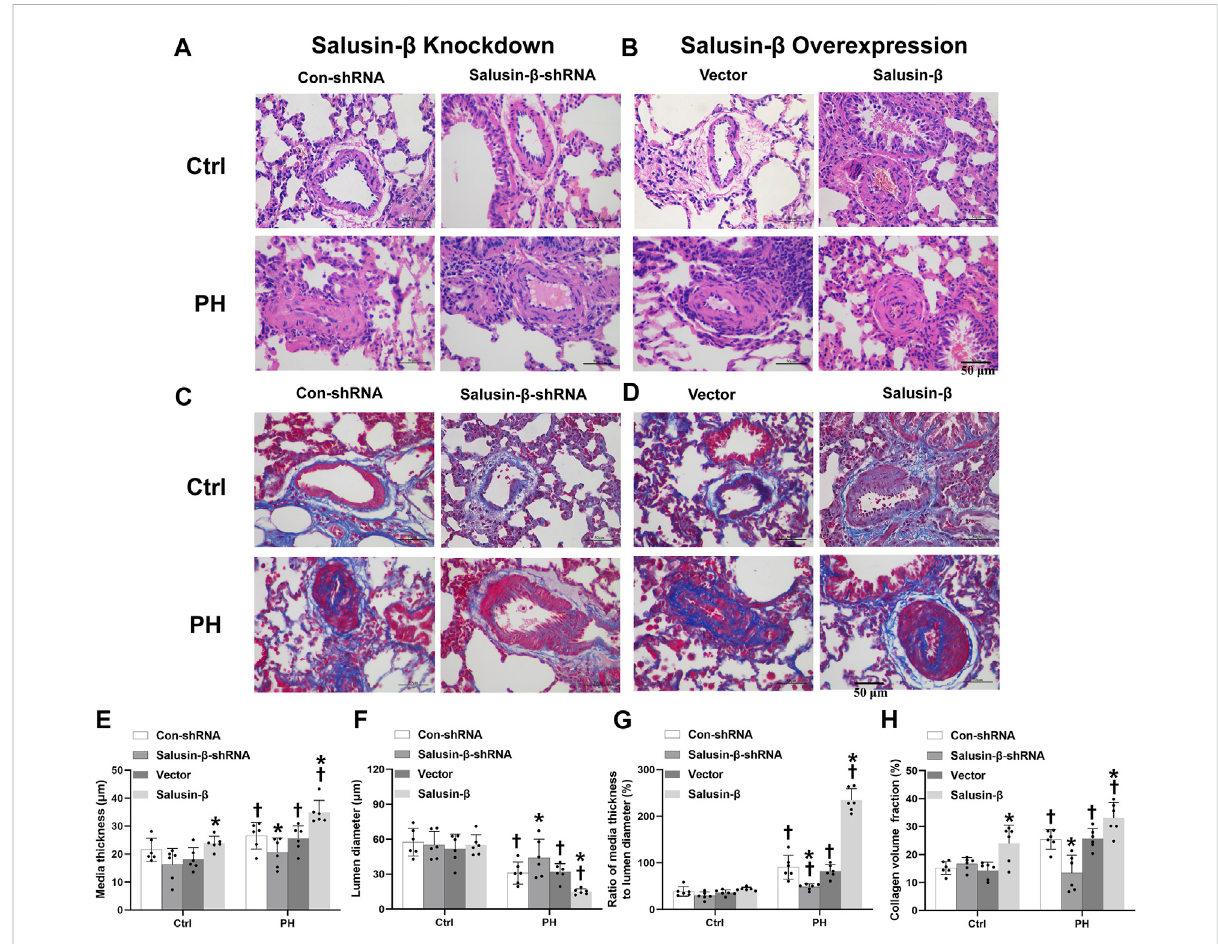
FIGURE 3 Representative images of lung tissue cross-sections with H and E staining (A) and Masson ’ s staining (Blue indicates collagen deposition) (C) showing the effects of salusin- β knockdown on PAs vascular remodeling and fi brosis; lung tissue cross-sections with H and E staining (B) and Masson ’ sstaining (D) showingtheeffectsofsalusin- β overexpressiononPAsvascularremodelingand fi brosis.Theeffectsofsalusin- β knockdownor overexpressiononthemediathickness (E) ,lumendiameter (F) ,mediathickness/lumendiameter (G) andcollagenvolumefraction(%) (H) ofPAs in control and MCT-induced PH rats. Values are mean ± SE. * p < 0.05 compared with Con-shRNA or vector. † p < 0.05 compared with control (Ctrl) rats. n = 6 for each